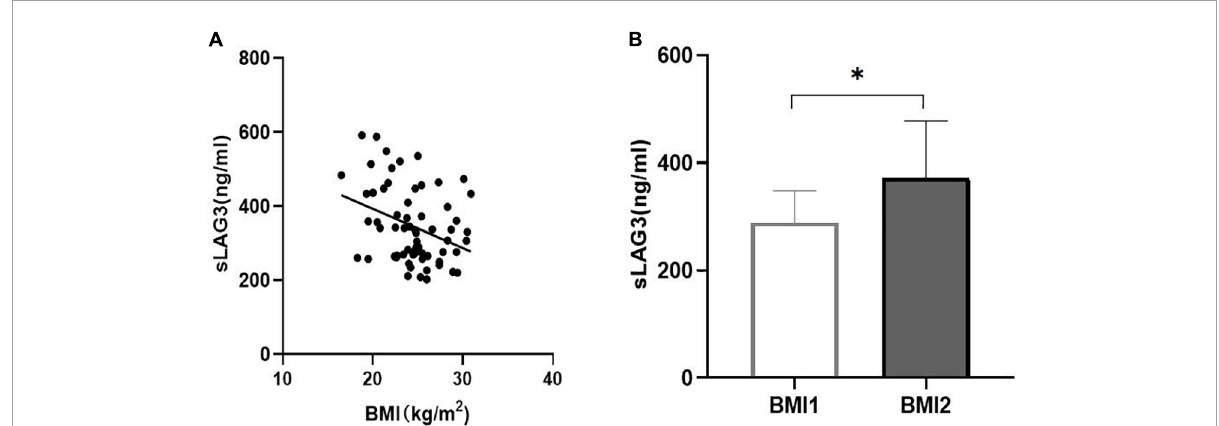
FIGURE3 The correlation between soluble lymphocyte activation gene-3 (sLAG3) and body mass index (BMI). (A) sLAG3 was negatively correlated with BMI ( r = − 0.314, P < 0.05). (B) The sLAG3 level according to BMI 24 kg/m 2 , BMI1 ≥ 24 kg/m 2 , BMI2 < 24 kg/m 2 . sLAG3 between two groups was compared using Mann-Whitney U -tests. ∗ P < 0.05.